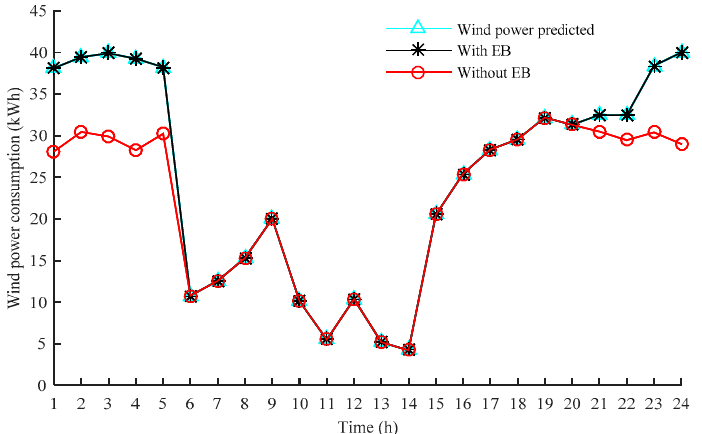
Figure 8. Comparison of wind power utilization.